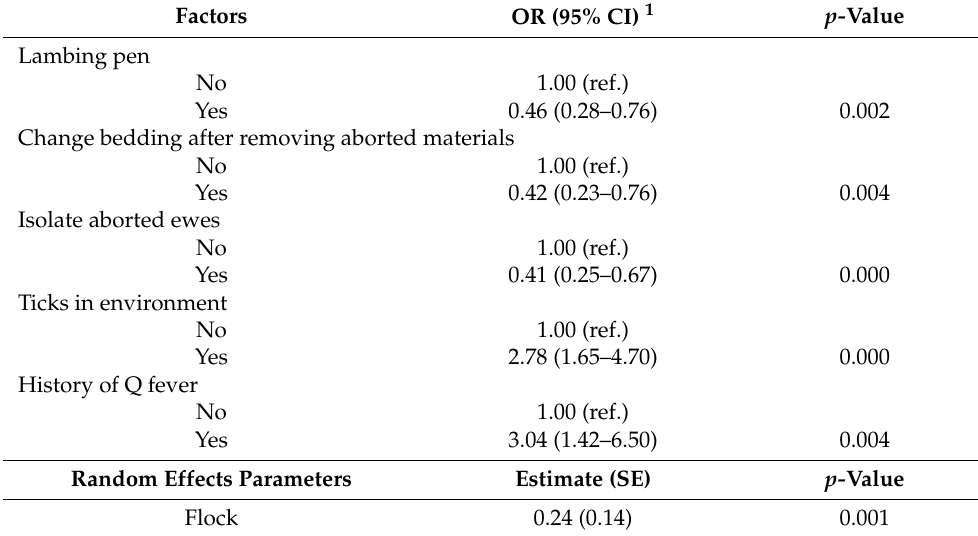
Table 2. Multivariable logistic regression analysis of flock management risk factors association ( p < 0.05) with Q fever seropositivity among sheep sampled from 50 flocks in Eastern Province, Saudi Arabia. Factors OR (95% CI) 1 p-